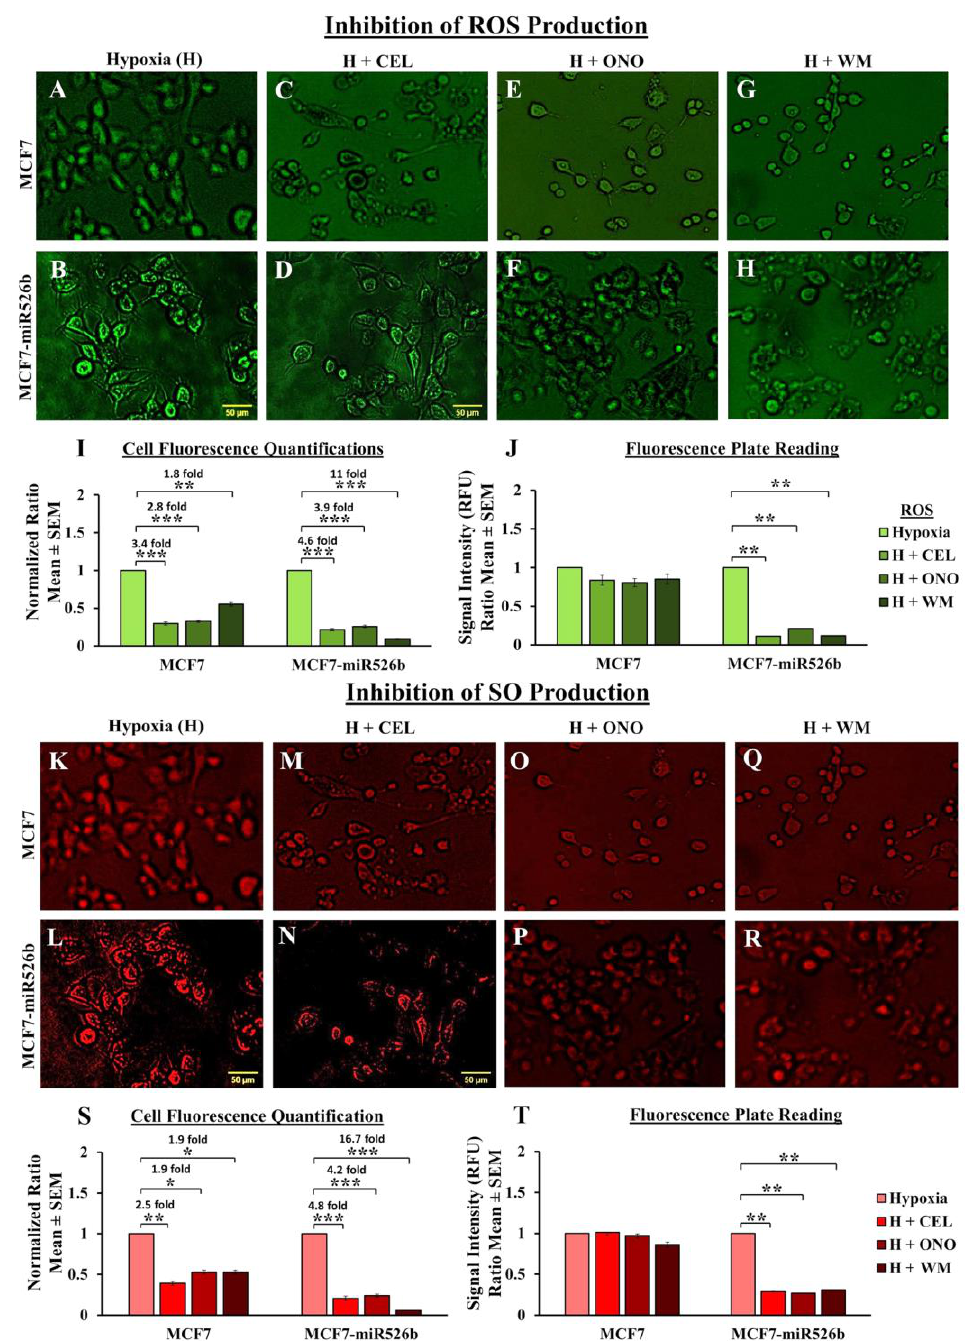
Figure 8. Inhibition of ROS and SO production: Representative MCF7 and MCF7-miR526b cells in ( A , B ) hypoxia, ( C , D ) hypoxia with CEL, ( E , F ) hypoxia with ONO, and ( G , H ) hypoxia with WM under the green filter for total ROS detection. ( I ) Quantification ratios for MCF7 and MCF7-miR526b cells positive for ROS. ( J ) Fluorescence microplate assay to quantify total ROS production. Fluorescent MCF7 and MCF7-miR526b cells in ( K , L ) hypoxia, ( M , N ) hypoxia with CEL, ( O , P ) hypoxia with ONO, and ( Q , R ) hypoxia with WM under the red filter for total SO detection. ( S ) Quantification ratios of MCF7 and MCF7-miR526b cells positive for SO. ( T ) Total SO production measured with fluorescence microplate assay. For all pictures, the scale bar represents 50 μM. Quantitative data are presented as the mean of three biological replicates ± SEM. * p < 0.05, ** p < 0.01 and *** p < 0.001.